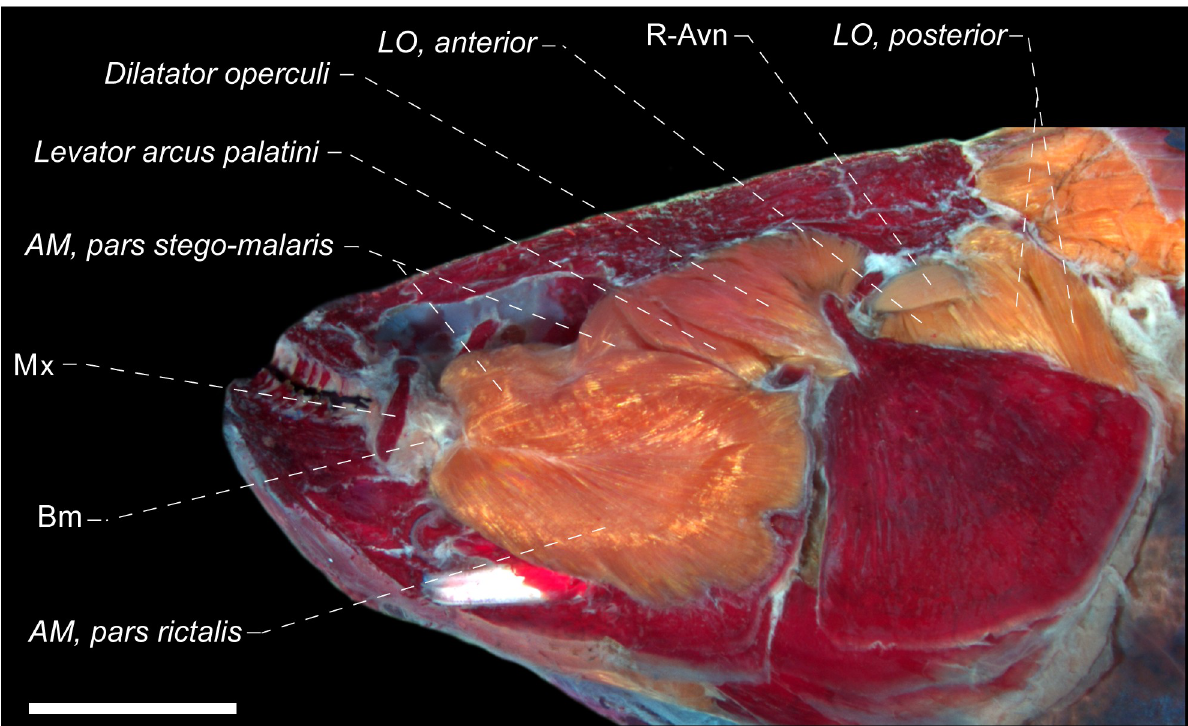
Fig 14. Lateral view of the dorsolateral head muscles of Gymnotus cylindricus , USNM 134701, 178.5 mm L EA . Am = adductor mandibulae ; Io = infraorbital; LO = levator operculi ; Mx = maxillary bone; R-avn = recurrent ramus of anteroventral part of anterior lateral line nerve; Rmt = ramus mandibularis trigeminus . Posterodorsal portion of LO, posterior accidentally removed. Scale: 4 mm.